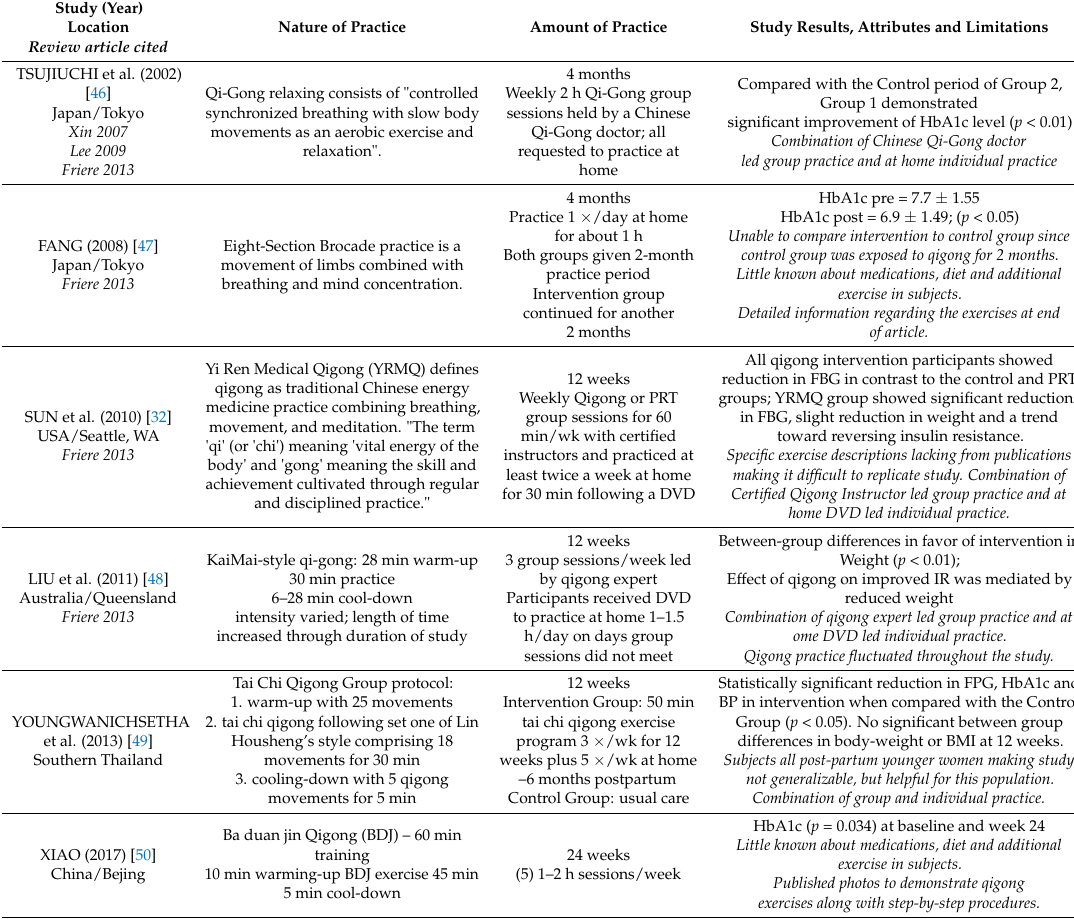
Table 2. Summary of randomized controlled trials (RCTs) Investigating the effects of qigong in adults with type 2